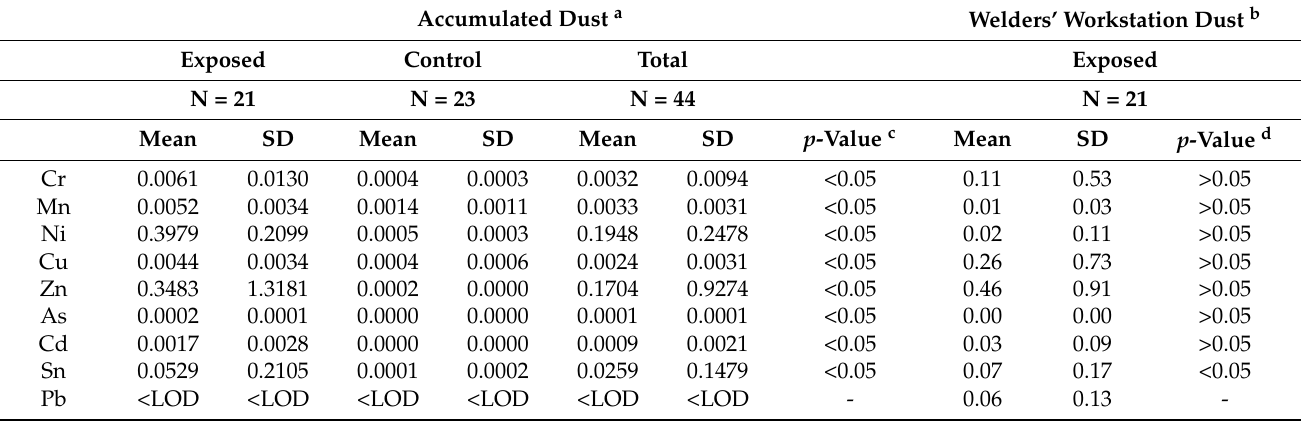
Table 2. PTE levels ( µ g/cm 2 ) in dust samples by group. Limeira, Brazil, 2019. Accumulated Dust a Welders’ Workstation Dust b Exposed Control Total